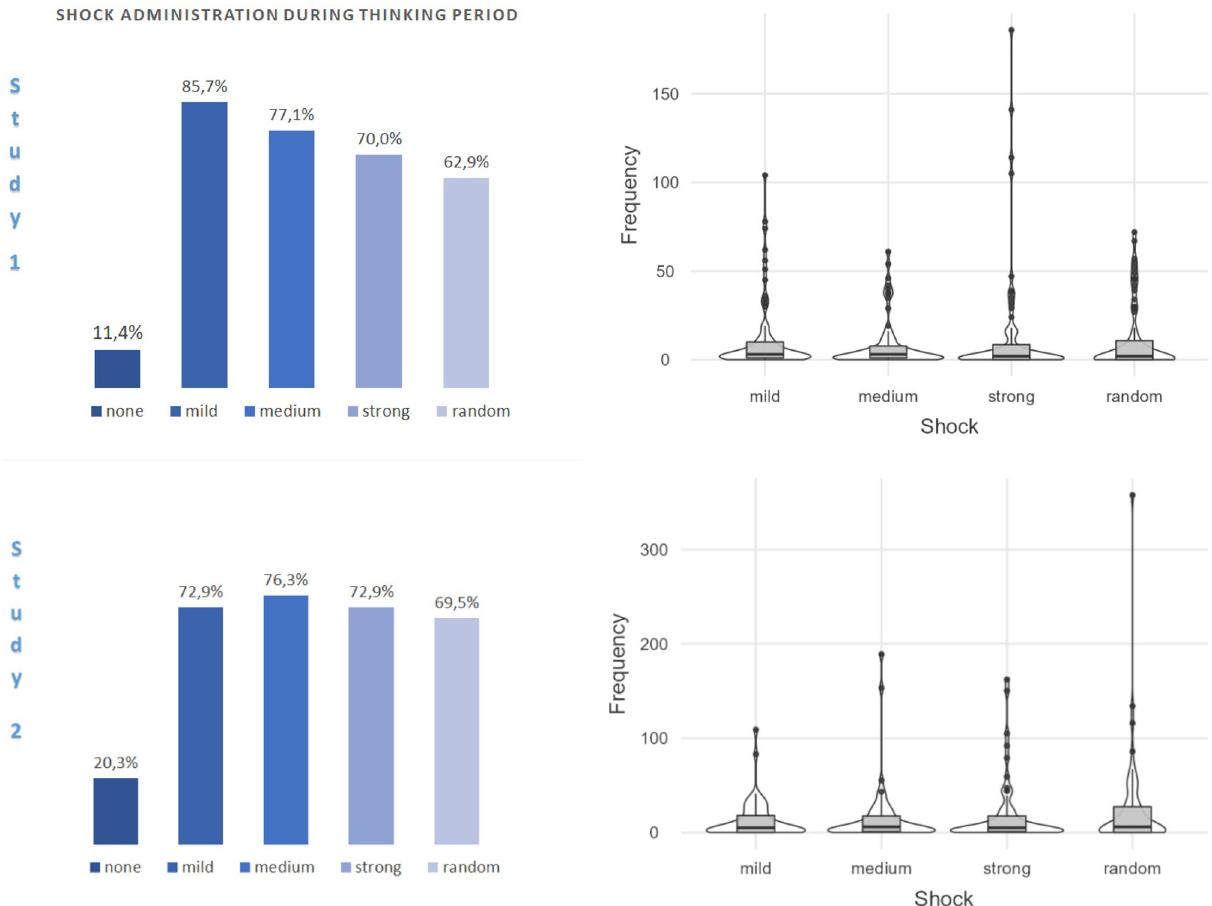
Figure 2. Left panel: proportions of participants who administered shocks to themselves during the thinking period. Note that the ‘none’ bar is mutually exclusive with the others; however, a participant can be counted in all other bars simultaneously. Right panel: violin plots with box plots of the frequencies of self-administered shocks as a function of shock intensity.